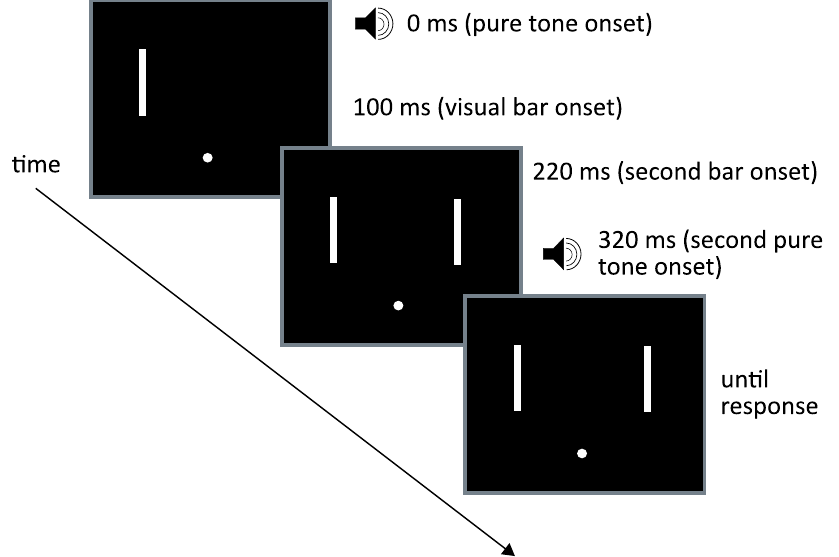
Figure 3. A depiction of a single experimental trial. In this trial, the cross-modal flankers are both pure tone audio, and are asynchronous with respect to the bars, which have a vSOA of 120 ms. In this trial the participant would be expected to report that the left bar appeared